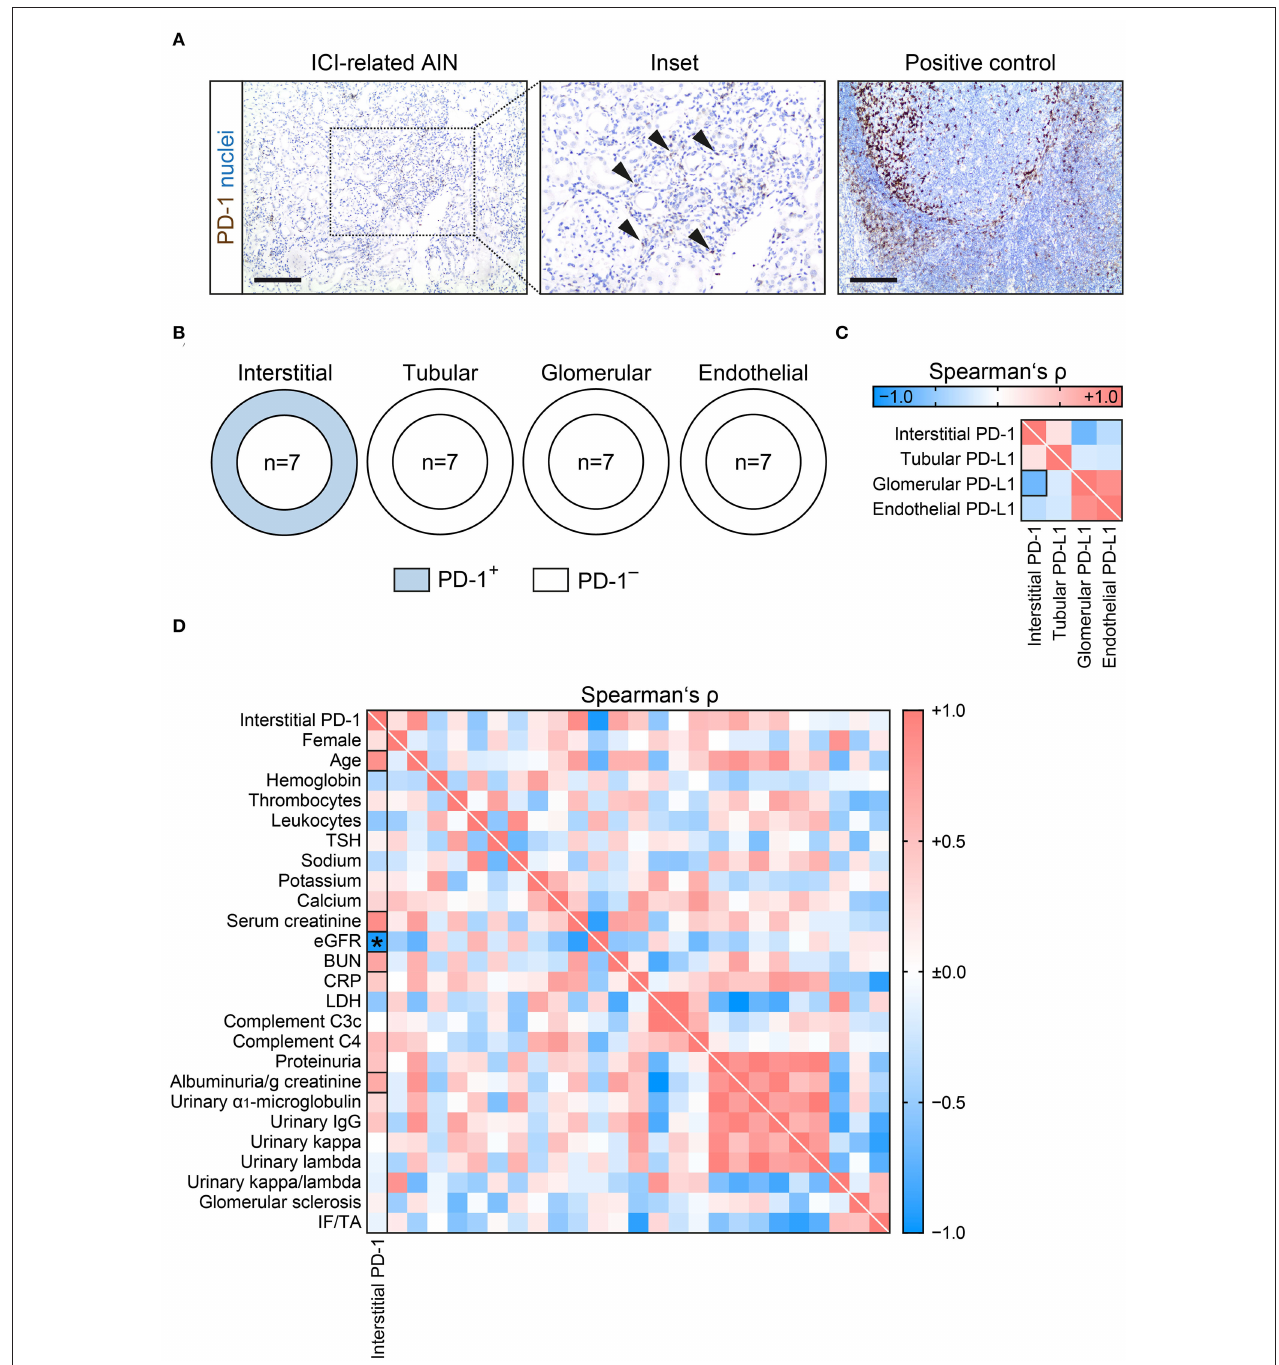
FIGURE 3 | PD-1 is present in interstitial cells and associates with kidney injury in ICI-related nephrotoxicity. (A) Interstitial cell PD-1 positivity (arrowheads) in AIN related to ICI therapy, tonsil tissue was used as positive control (scale bar: 200 µ m). (B) Frequency of PD-1 positivity among different renal compartments. (C) Correlative analysis of interstitial PD-1 and PD-L1 positivity within different renal compartments in ICI-related nephrotoxicity are shown by heatmap reflecting mean values of Spearman’s ρ . The rectangle box indicates a Spearman’s ρ more than ± 0.6. (D) Extent of interstitial cells positive for PD-1 in ICI-related nephrotoxicity in association with clinical and laboratory parameters are shown by heatmap reflecting mean values of Spearman’s ρ . Rectangle boxes indicate a Spearman’s ρ more than ± 0.6, asterisks significant correlations in the stepwise linear regression analysis ( p < 0.05). AIN, acute interstitial nephritis; BUN, blood urea nitrogen; C3c, complement factor 3 conversion product; C4, complement factor 4; CRP, C-reactive protein; eGFR, estimated glomerular filtration rate (CKD-EPI); ICI, immune checkpoint inhibitor; IF/TA, interstitial fibrosis/tubular atrophy; IgG, immunoglobulin G; LDH, lactate dehydrogenase; PD-1, programmed cell death protein 1; PD-L1, programmed cell death protein 1-ligand 1; TSH, thyroid stimulating